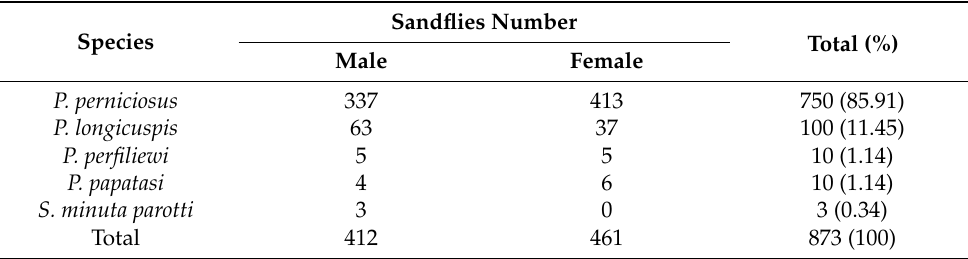
Table 1. Abundance of sandflies collected by CDC light traps in the Utique site in 2009.